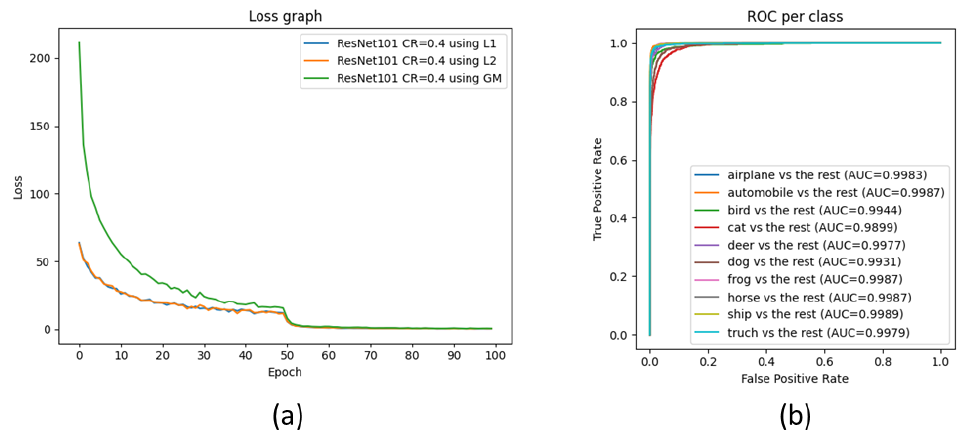
Figure 5. ( a ) Training loss for ResNet101 pruned at 40% using L1, L2, and GM methods and ( b ) the ROC curve per class for the best ResNet101 pruned by the L1